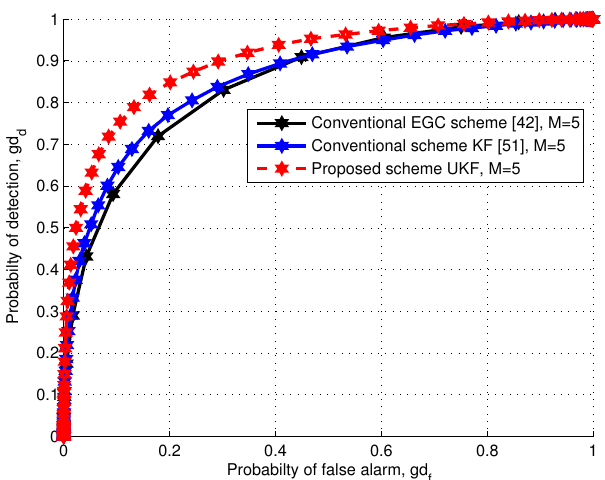
Figure 7. Detection gain comparison between an equal gain combining (EGC), Kalman filter (KL) and unscented Kalman filter (UKF) with different numbers of CUs, i.e., M = 5 and signal to noise ratio (SNR) = [ − 8, − 11, − 14, − 17, − 20].